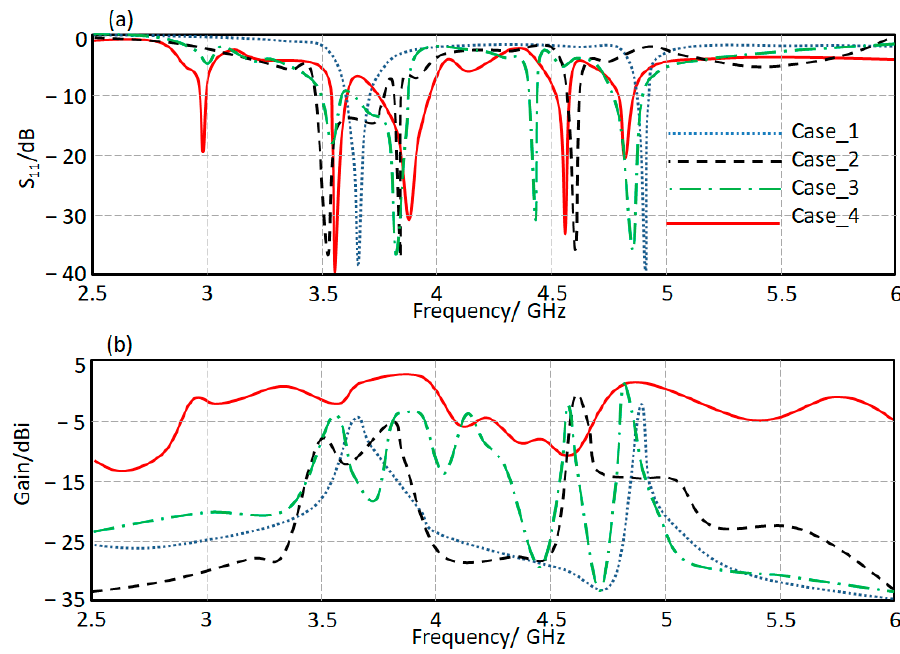
Figure 5. Antenna performance based on a single antenna element: ( a ) S11 and ( b ) Gain.